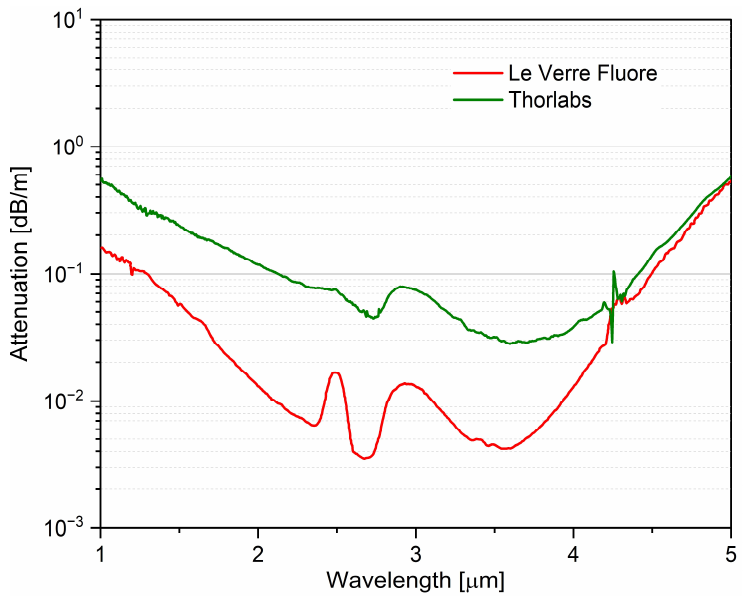
Figure 2. Attenuation spectra of selected single-mode fluoroindate fibers (data provided by manufacturers [93,94]).